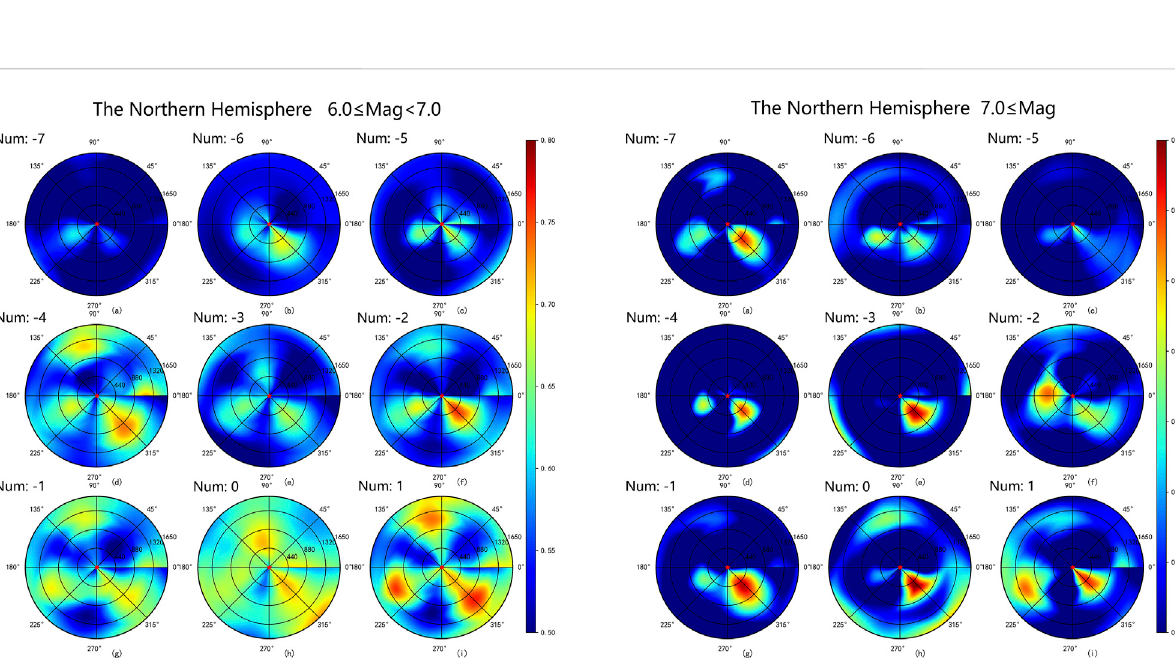
areas increased; the anomalous values in the southern part of the region reached the highest value of 8.0 the 9 – 5 days before the earthquake; during the pre-seismic cycle, the values are high in most areas of the earthquake preparation zones; after the earthquake, the values start to decrease in some areas. Observe the graph on the right to get for earthquakes of magnitude 7.0 or higher in the Southern Hemisphere, the numerical range of the entire earthquake preparation zones fl uctuates between 0.50 and 1.10 and